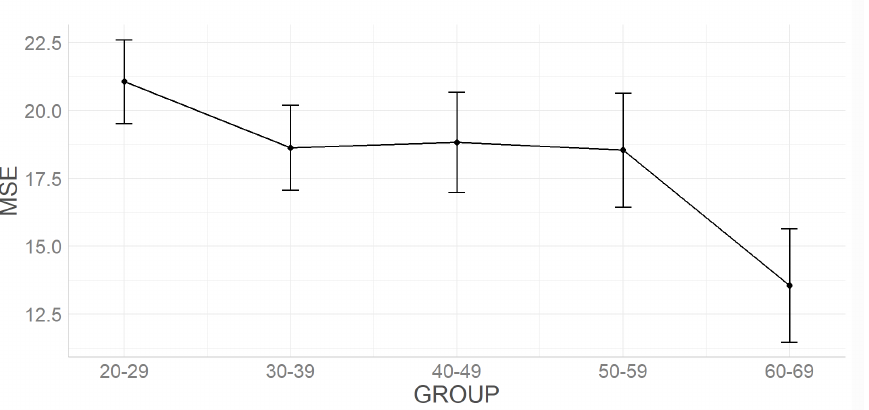
Figure 5. Mean and confidence intervals of VAG signal parameters in the further decades of life—for MSE